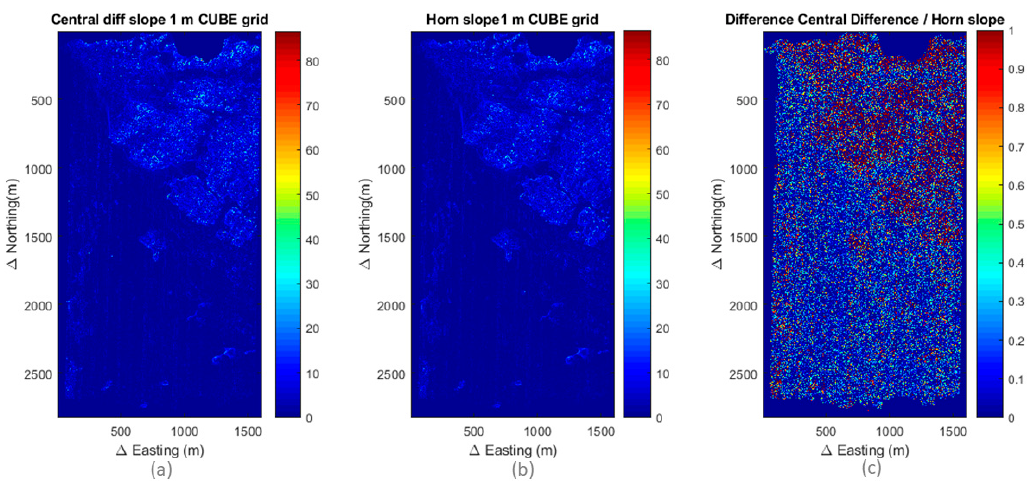
Figure 12. Comparison of the estimated magnitude of slopes from the entire survey area using the ( a ) central difference and ( b ) Horn methods applied to data gridded to 1 m cell sizes. ( c ) Difference in slope computed using the two methods shows that it is <0.3° in flat areas and <1° in rough areas.